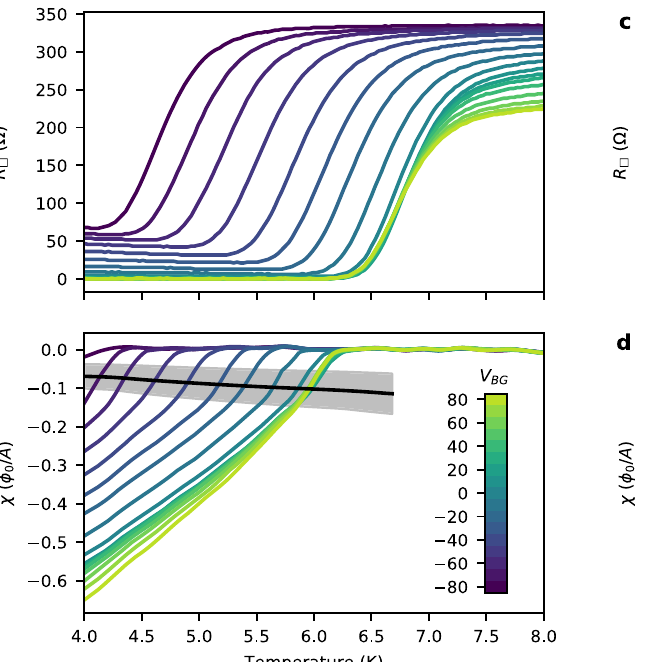
condition ρ s =2 T / π . The gray shaded area indicates uncertainty in the universal conditionarisingfromuncertaintyintheSQUIDheight. c , d Sameasin a , b butfor device